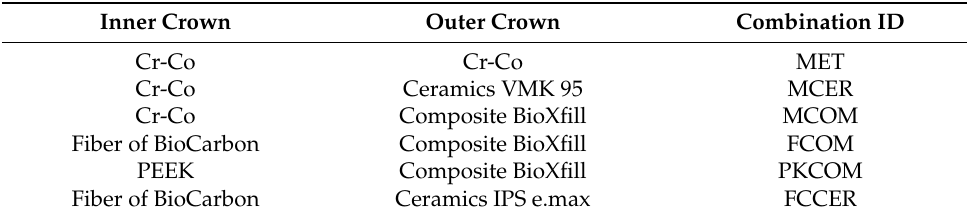
Figure 15. Whole implant and load plate ( w p = 10, h p = 12, e p = 2 mm). For simplicity, the bone structure is not shown. Table 1. Common combination of materials for inner and outer crowns.